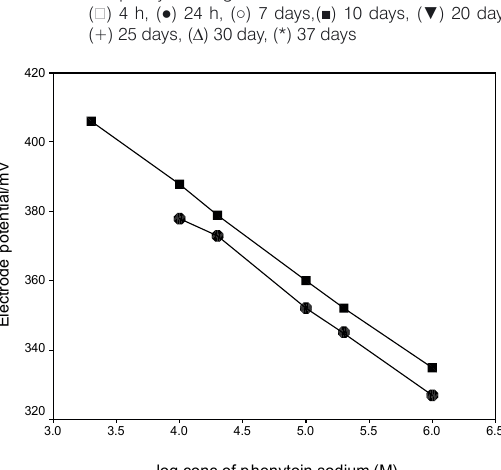
Figure 7. Regeneration of phenytoin-tungstosilicate-coated wire electrode ( ● ) calibration graph of the exhausted electrode, ( ■ ) calibration graph of a regenerated electrode